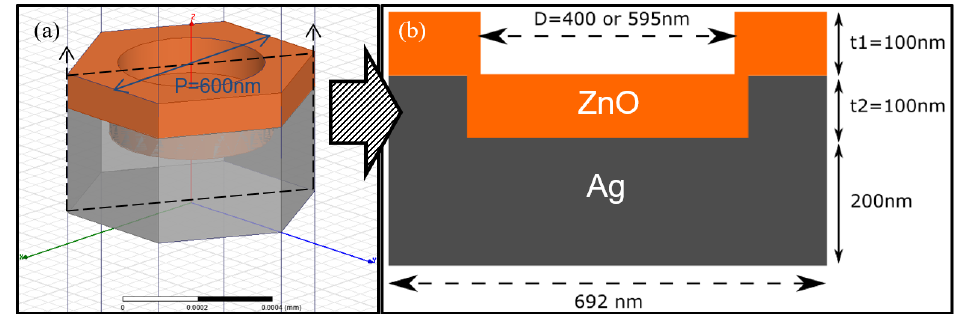
Figure 7. Simulated hexagonal nanostructured back reflector; ( a ) HFSS unit cell in the simulation model and ( b ) corresponding cross sectional view.